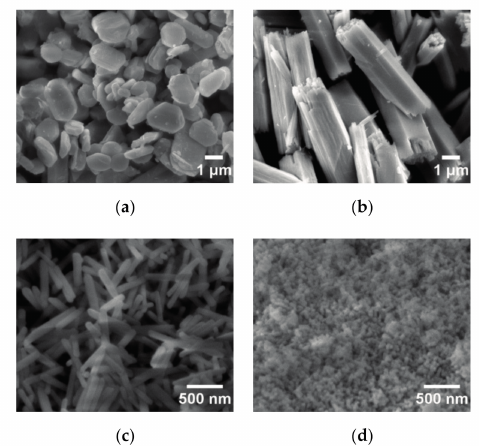
Figure 6. SEM images of the products obtained at 160 ◦ C for 24 h as a function of the pH value of the starting solution. The pH value used is 7.26 ( a ), 8.99 ( b ), 10.48 ( c ), 12 ( d